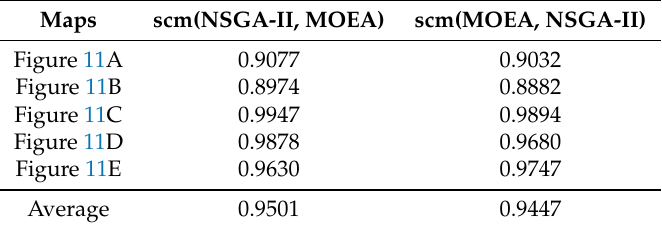
Table 3. The results of the set coverage metric.